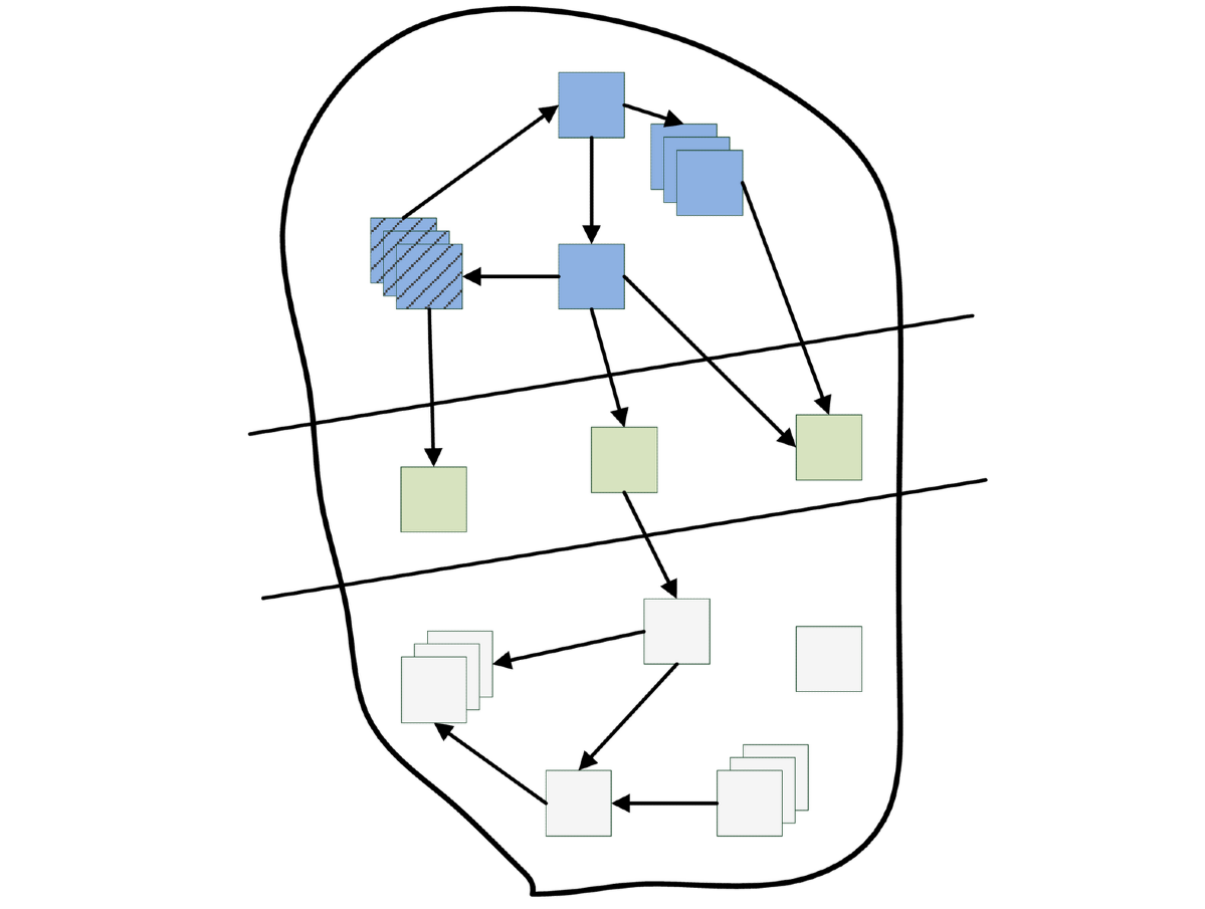
Figure 1. Schematic representation of the web graph traversal by a crawler. Pages colored in blue represent processed pages; in green, pages referenced in the frontier; in gray, undiscovered web content. Pages in dashed blue represent so-called initial seed